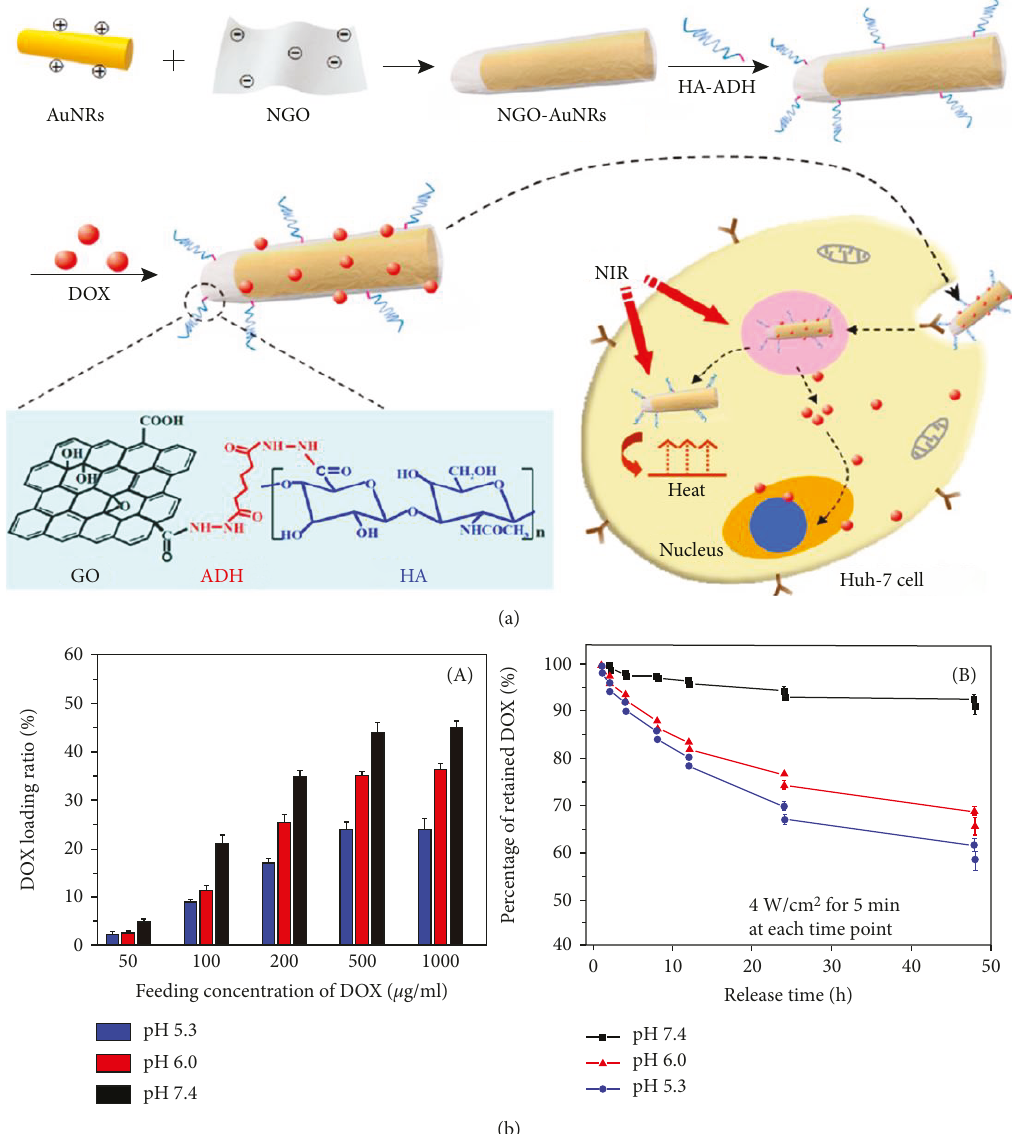
Figure 5: (a) Schematic illustration for the synthesis of NGOHA-AuNRs-DOX and the possible mechanism in targeted chemophotothermal therapy to hepatoma Huh-7 cells. (b, A) pH-dependent DOX loading e ffi ciency of NGOHA-AuNRs at di ff erent DOX feeding concentrations. (B) Cumulative release pro fi les of DOX from NGOHA-AuNRs-DOX at di ff erent pH values with 4 W/cm 2 NIR light irradiation at each time point for 5 min. Data represent mean values for n = 3 , and the bars are standard deviations for the means